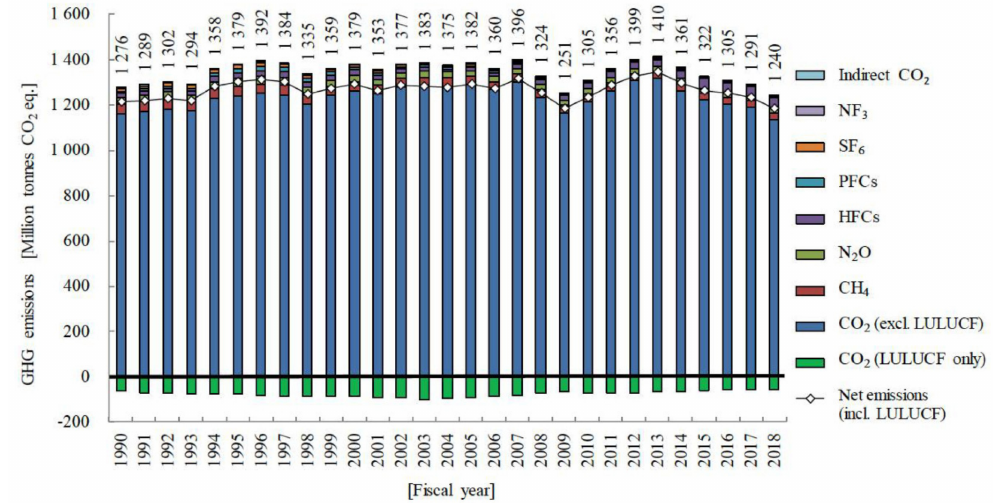
Figure 3. Trendsingreenhousegas(GHG)emissionsandremovalsinJapan. Source: NIES:NationalInstitute for Environmental Studies [54] (page 2–1).